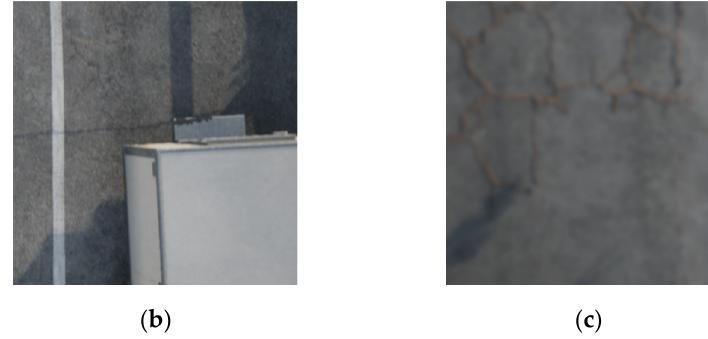
Figure 5. Schematic diagram of 3 types of virtual pavement distress under complex scenarios. ( a ) Shadow. ( b ) Occlusion. ( c ) Blur.